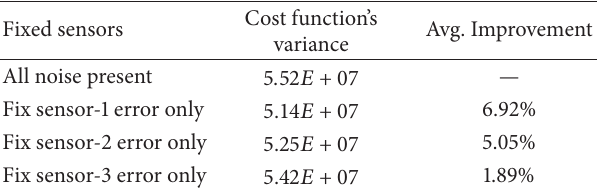
Table 3: Error elimination of sensors with perfect knowledge (KPI- 2).